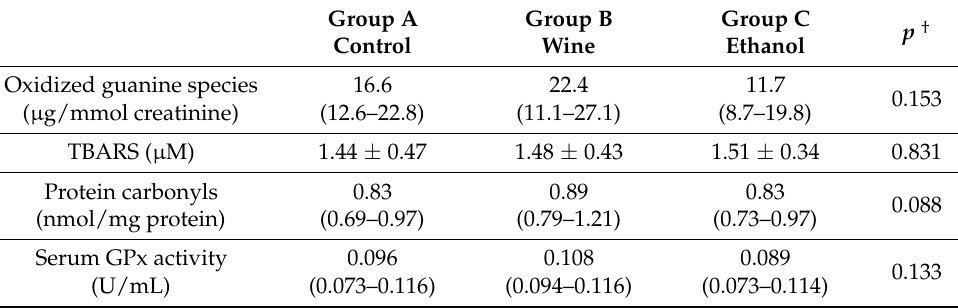
Table 2. Oxidative stress biomarkers’ levels before intervention (0